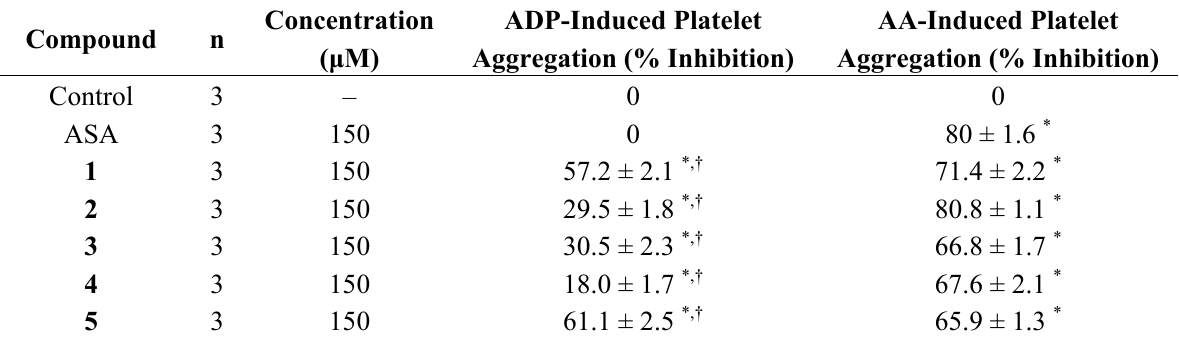
Table 1. Effects of NAH derivatives 1 – 5 (150 μ M) and ASA (150 μ M) on the